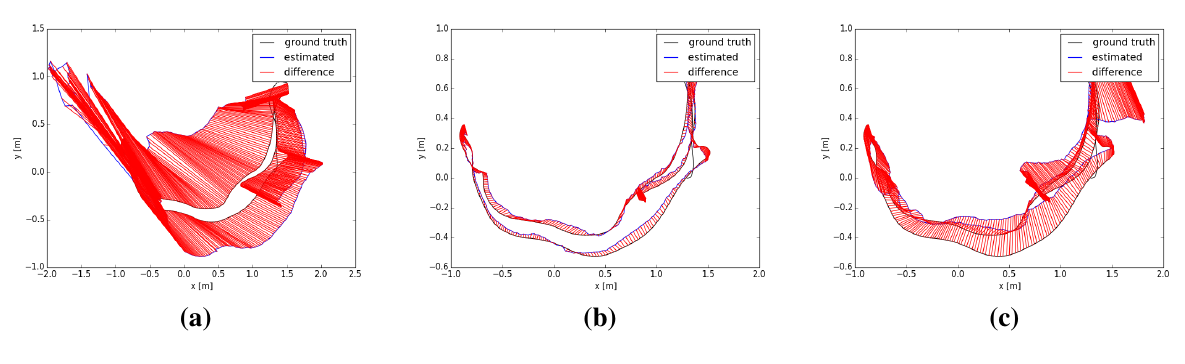
Figure 13. Trajectories estimated on the dataset “fr1 desk2” by the KinectFusion ( a ), the dense visual odometry ( b ) and the visual features + ICP ( c )